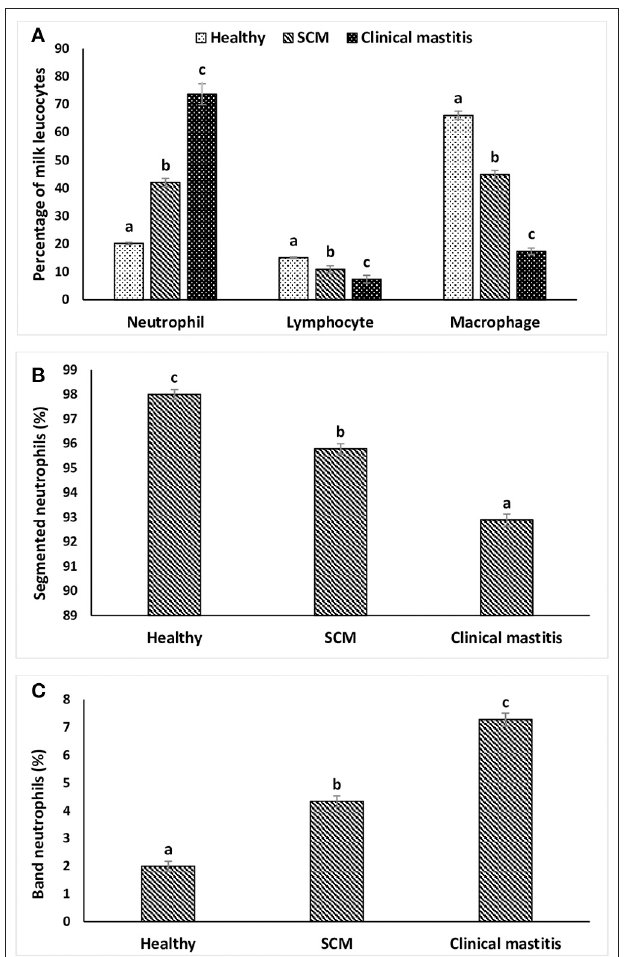
FIGURE 2 | Differential milk leukocyte counts. (A) The percentage of milk neutrophils, macrophages, and lymphocytes; (B) segmented neutrophils; (C) band neutrophils in healthy, subclinical mastitis (SCM), and clinical mastitis Sahiwal cows. Data were expressed as mean ± SEM. Means statistically ( p < 0.05) different between the groups are shown with superscript letters